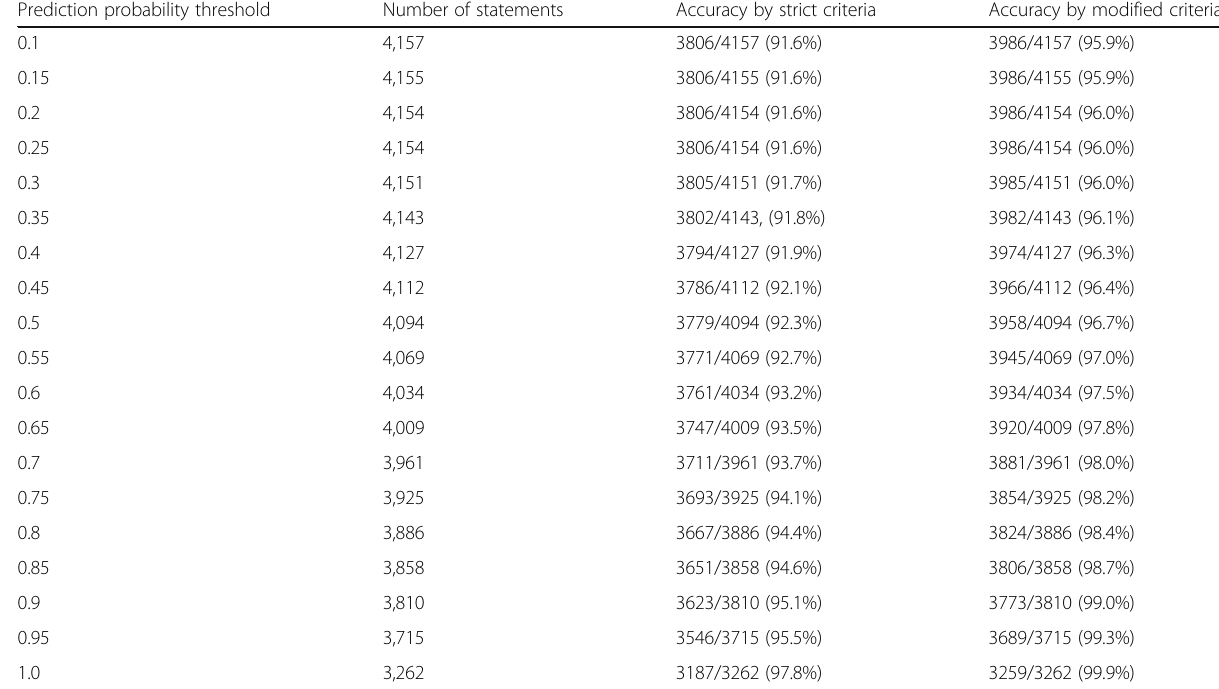
Table 2 Accuracy stratified by prediction probability Prediction probability